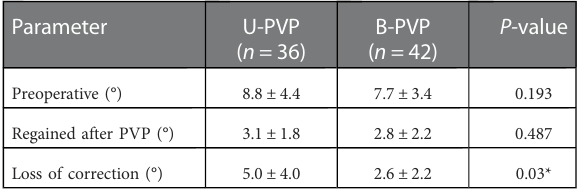
TABLE 4 Preoperative and postoperative coronal cobb (C-Cobb) angle and loss of correction during the